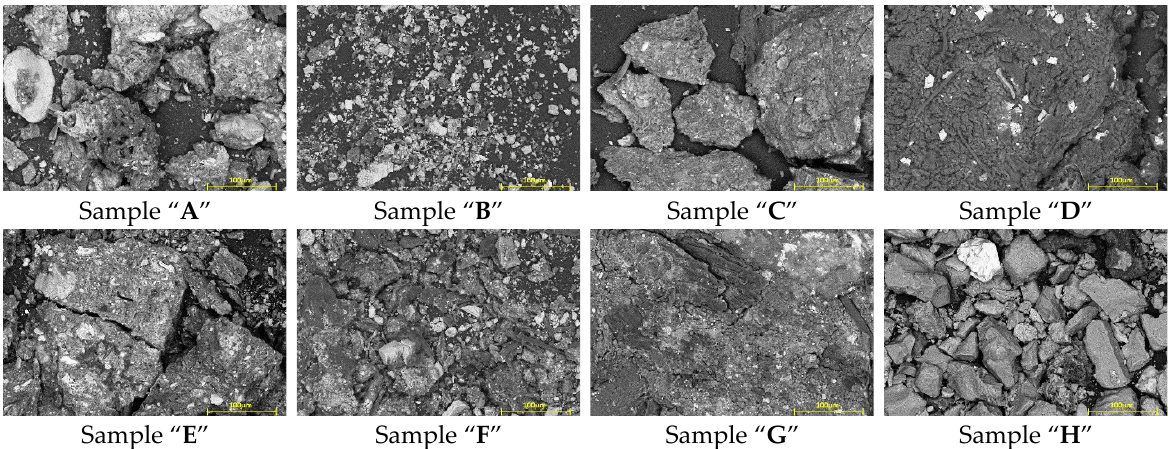
Figure 1. SEM images of the dried raw materials.